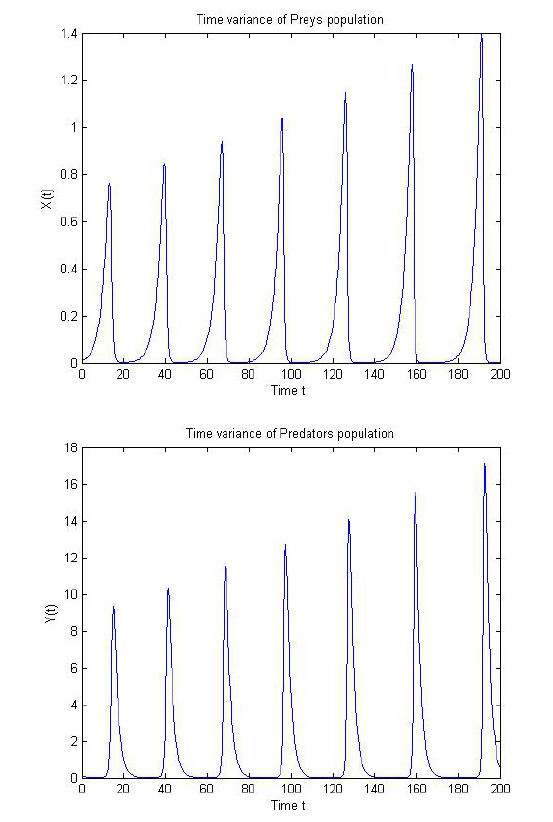
Fig. 5. The positive equilibrium remains unstable for τ 1 = 1 < τ 1 c = 6 and τ 2 = 0 .